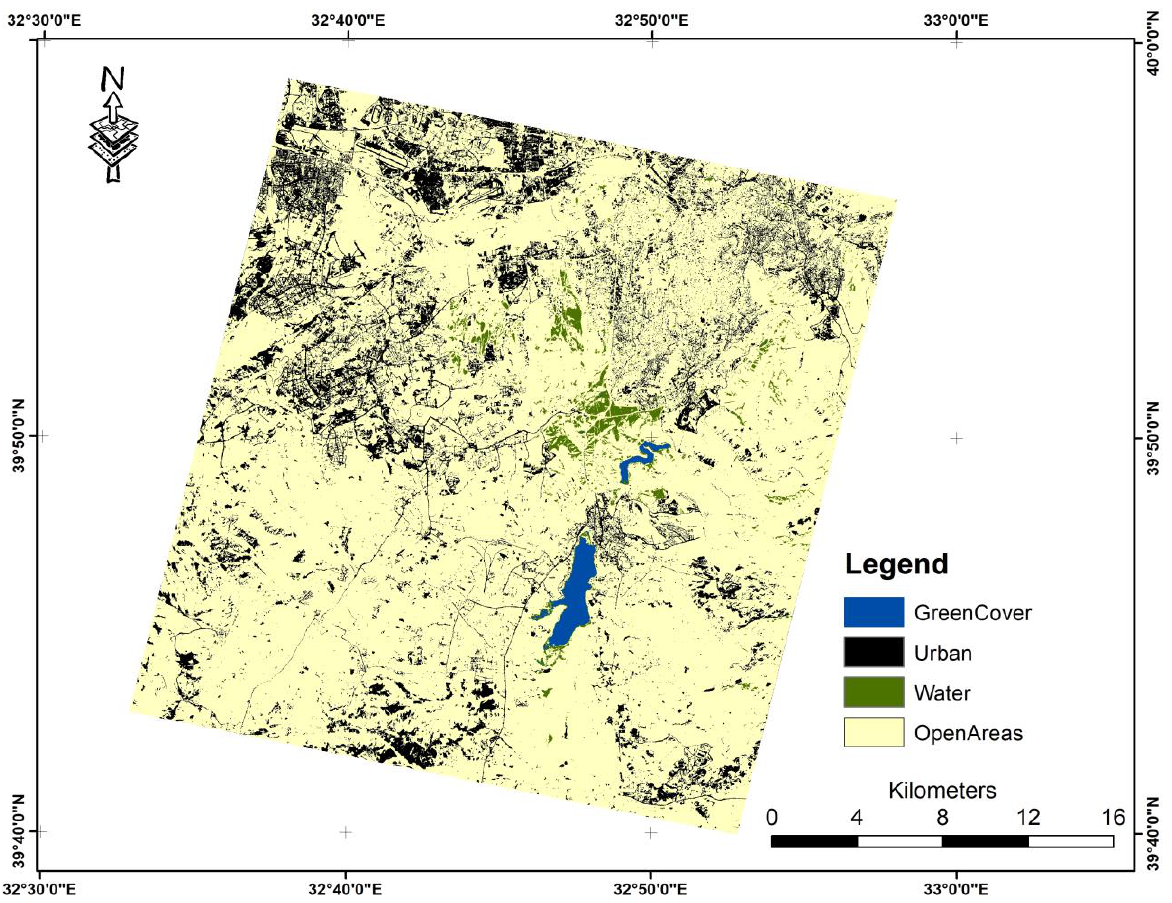
Figure 6 RASAT image and classified LULC